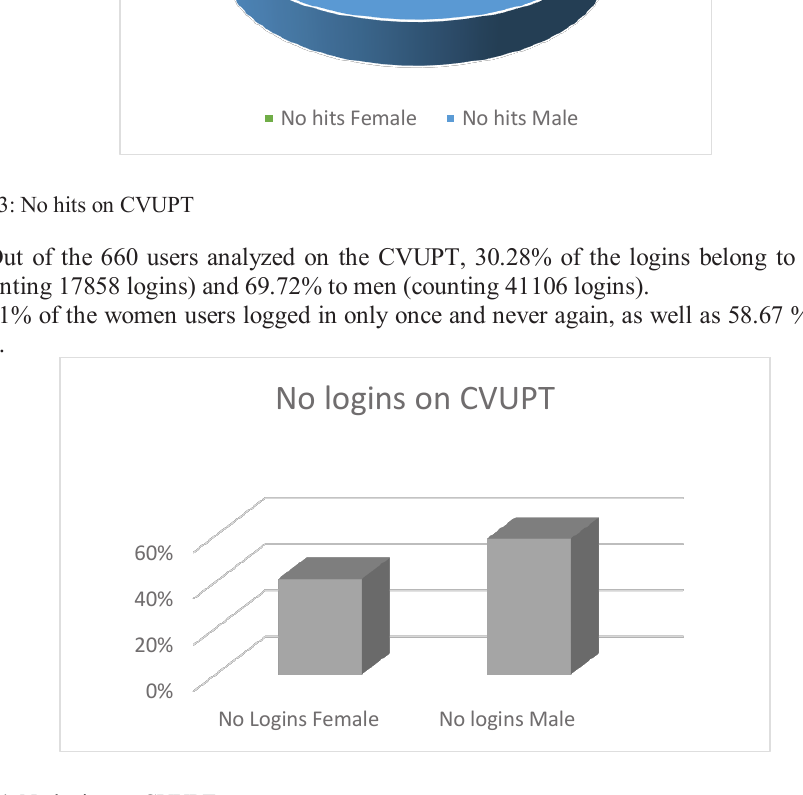
Fig. 2: Total number of hits on the CVUPT platform, according to